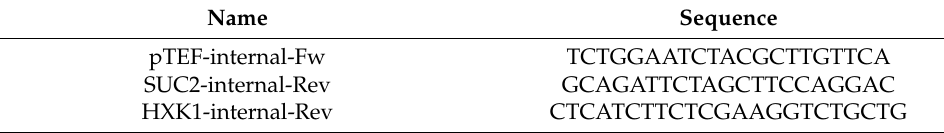
Table 2. Sequence of primers used in this